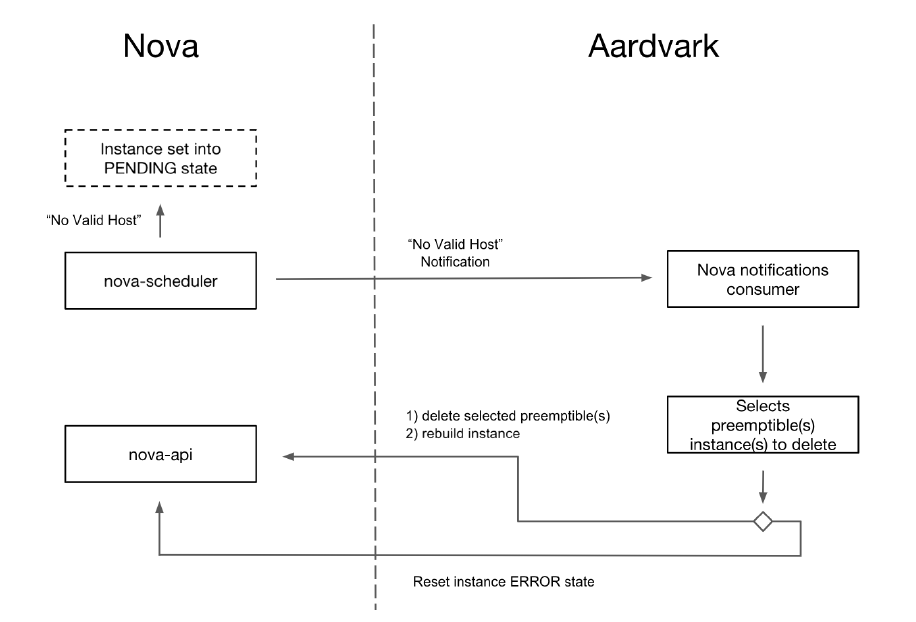
Figure 1. The Aardvark service